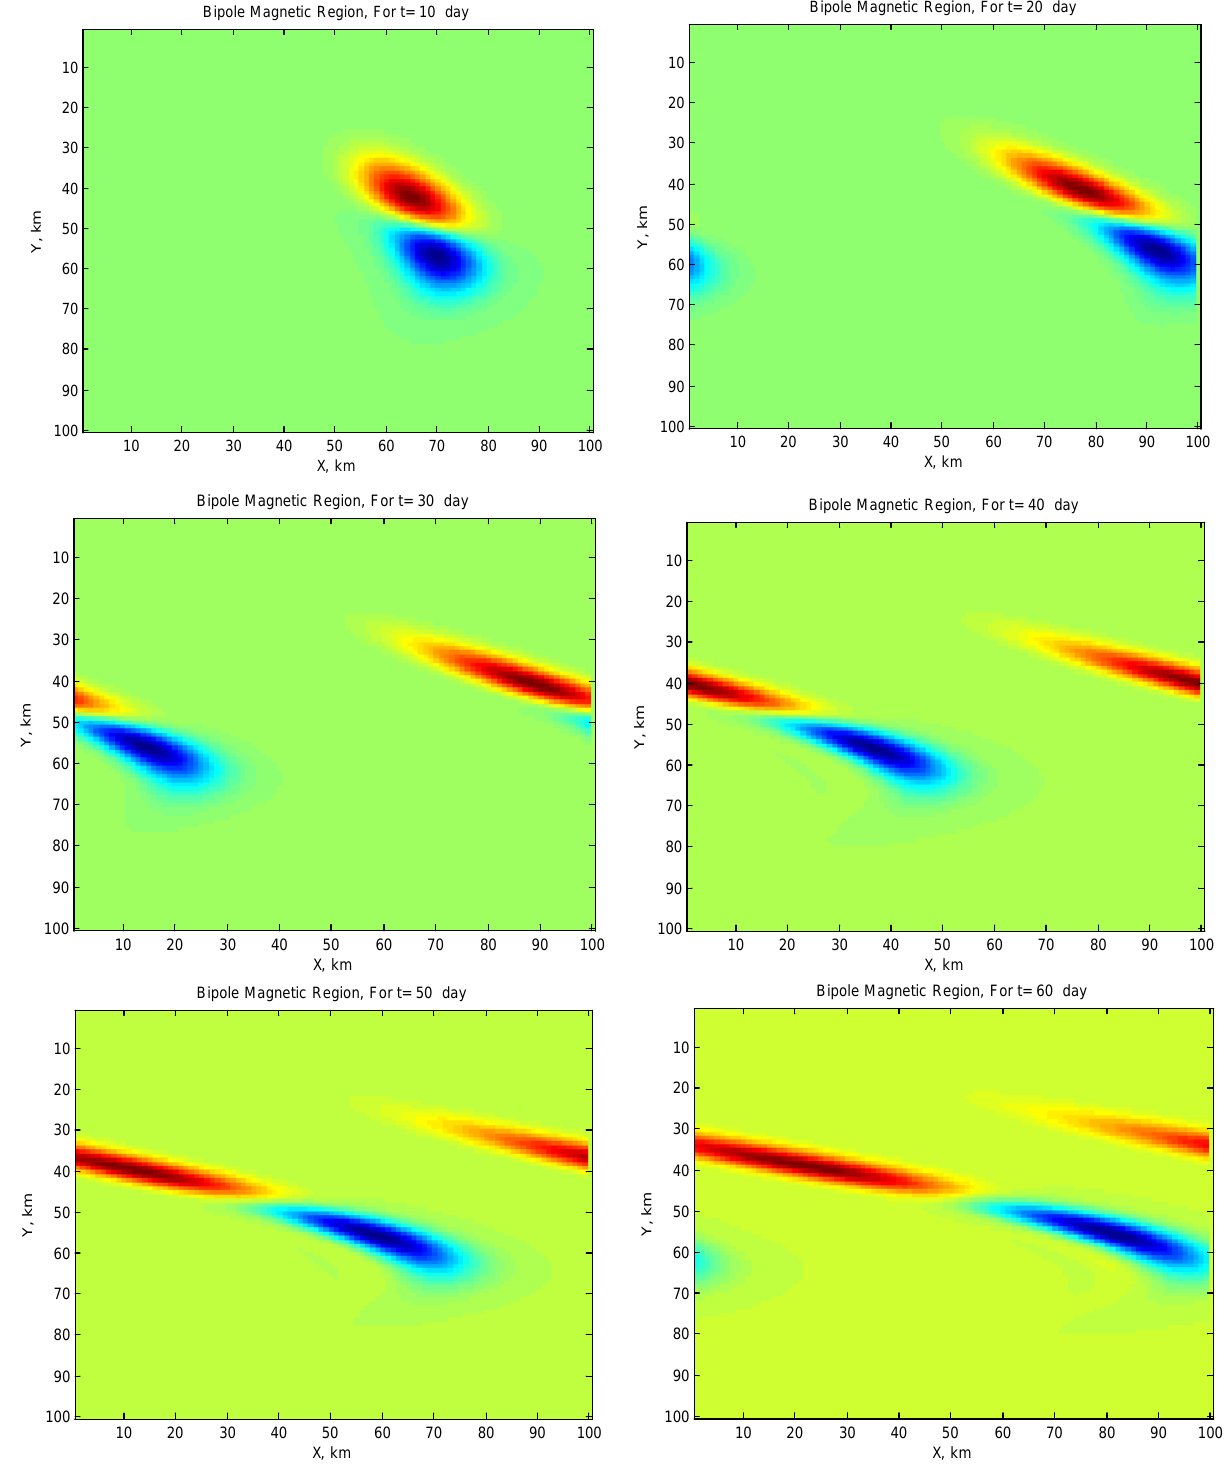
Fig. 7: Explicit numerical solution of equation of magnetic transport flux for 60 days and